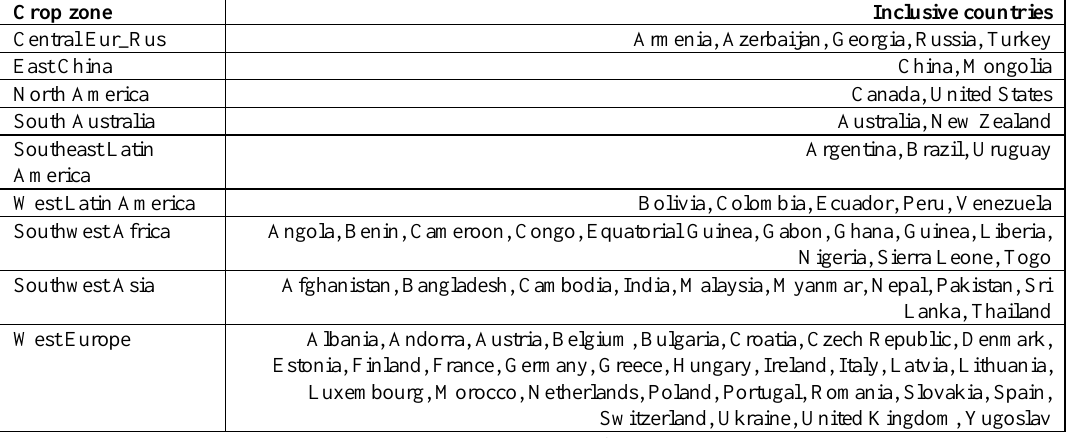
Table S1. The inclusive countries list of nine major crop